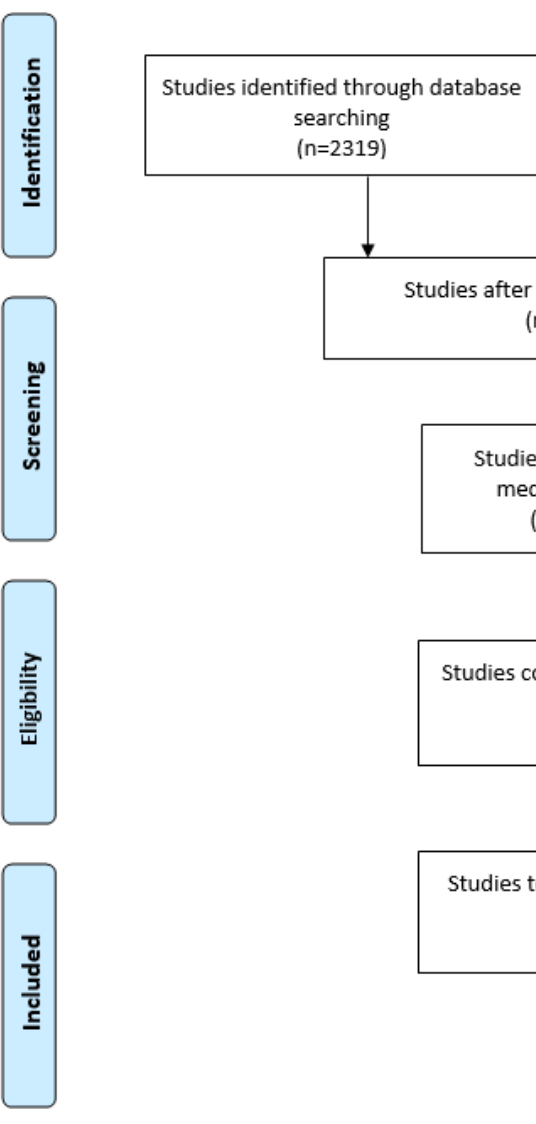
Figure 3. Data collection